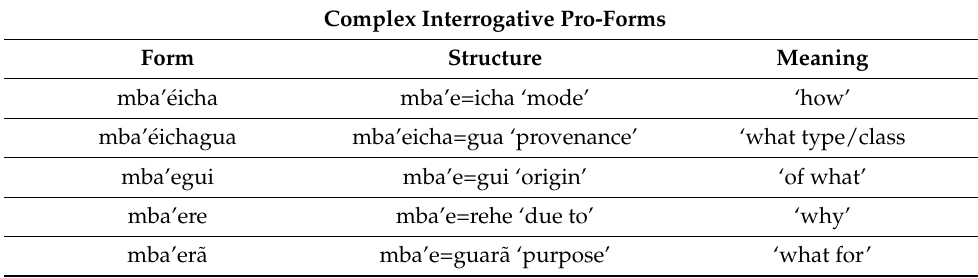
Table 1. Morphological structure of interrogative pro-forms in Guaran í